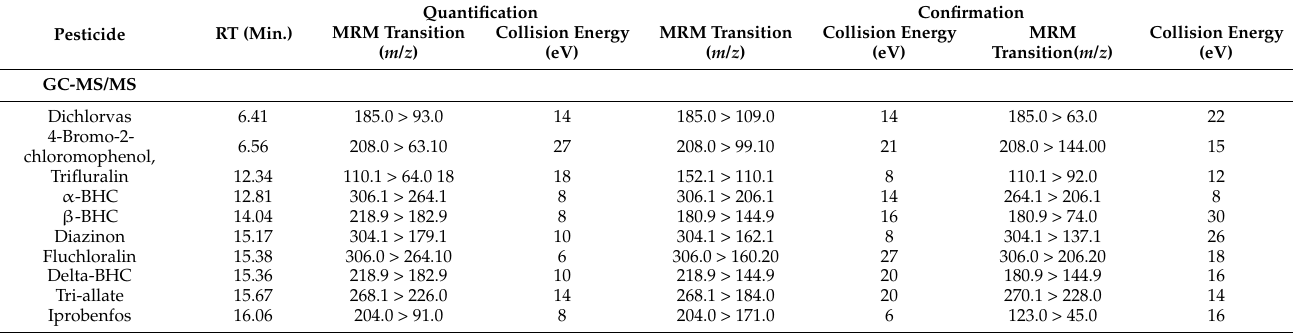
Table 1. Retention time, mass spectrometric parameters for multiclass pesticides analyzed in tomato and Capsicum . Quantification Confirmation MRM Pesticide RT (Min.)